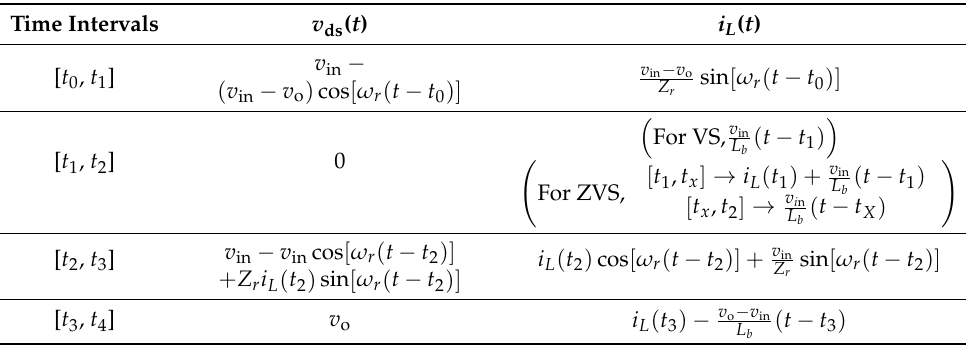
Table 1. Expressions for v ds and i L depending on the time intervals. Time